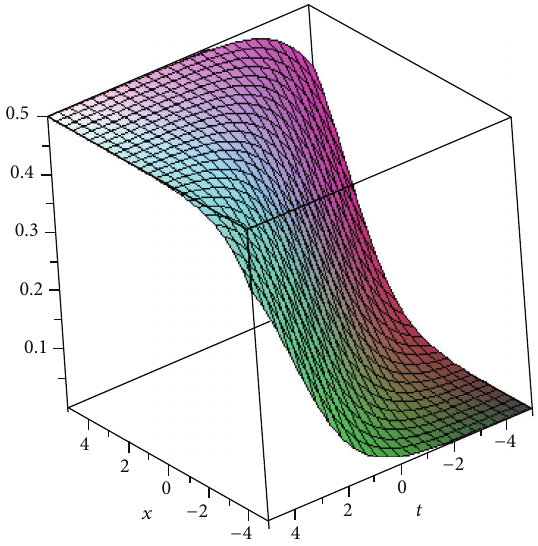
Figure 6: The plot of solution (42) with 𝑎 = 𝑏 = 1 , 𝑅 = 𝑛 = 2 .